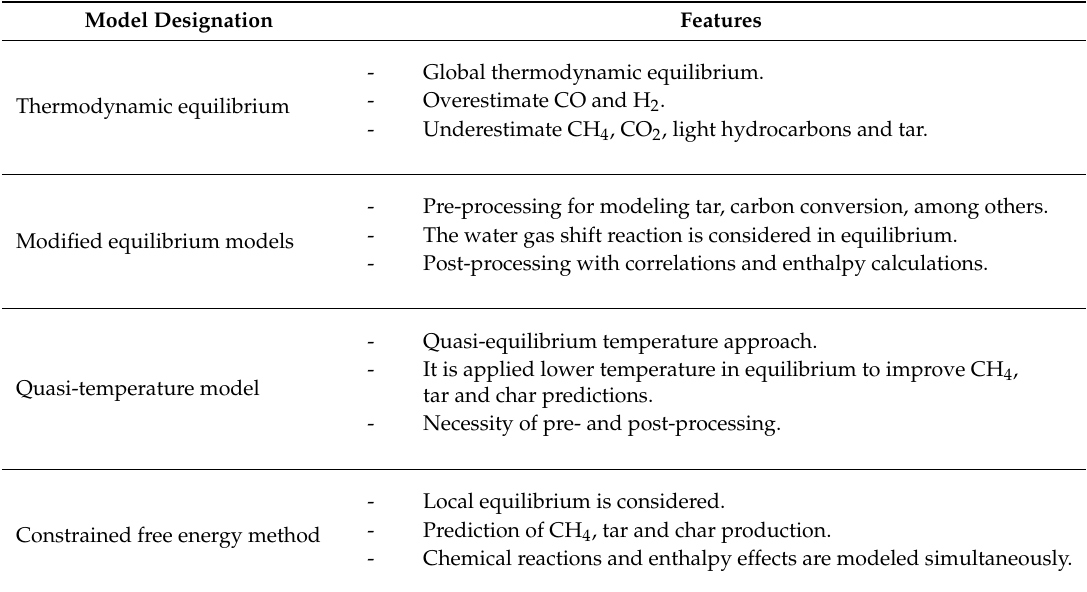
Table 2. Thermodynamic modeling structures applied in biomass gasification. Adapted from